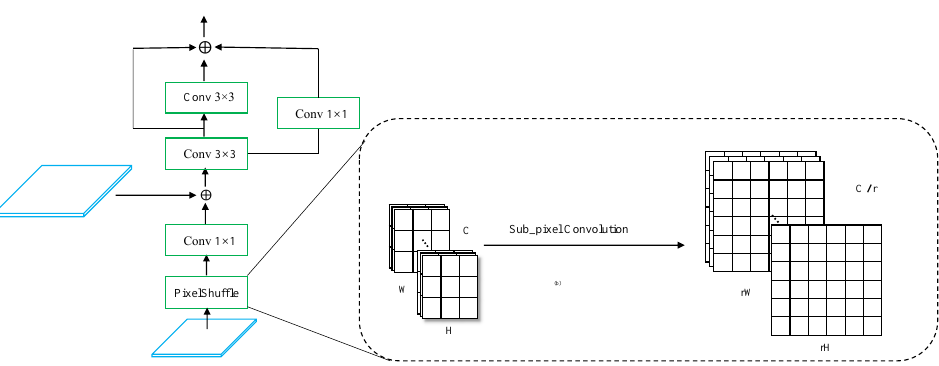
Figure 5. The structure of pixelshuffle convolution upsample